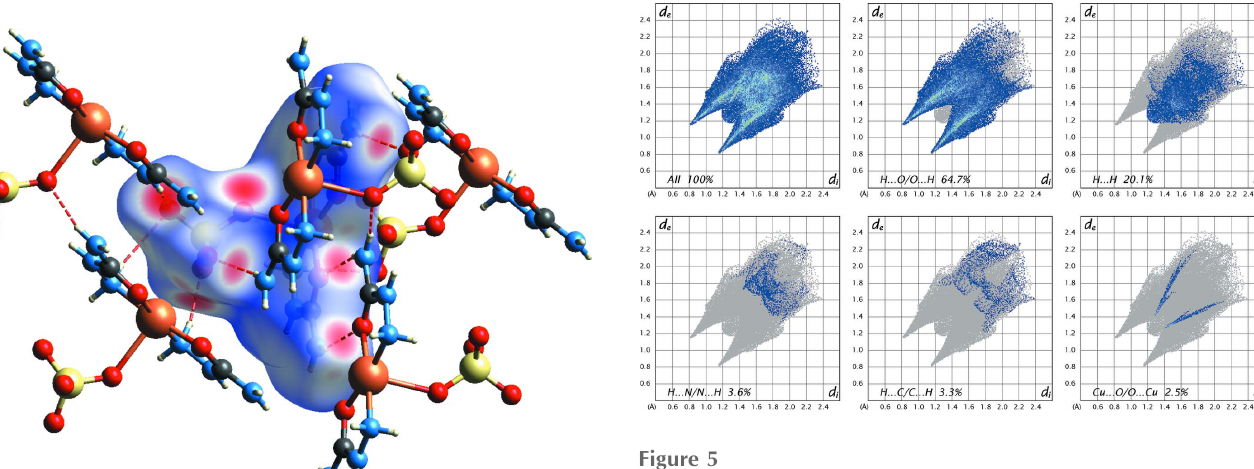
Figure 5 The full two-dimensional fingerprint plot of [Cu(SEC) 2 (SO 4 )] n showing all interactions and those delineated into O (cid:2)(cid:2)(cid:2) H/H (cid:2)(cid:2)(cid:2) O, H (cid:2)(cid:2)(cid:2) H, N (cid:2)(cid:2)(cid:2) H/ H (cid:2)(cid:2)(cid:2) N, C (cid:2)(cid:2)(cid:2) H/H (cid:2)(cid:2)(cid:2) C and C (cid:2)(cid:2)(cid:2) O/O (cid:2)(cid:2)(cid:2) C interactions. The d i and d e values are the closest internal and external distances (A˚ ) from given points on the Hirshfeld surface.